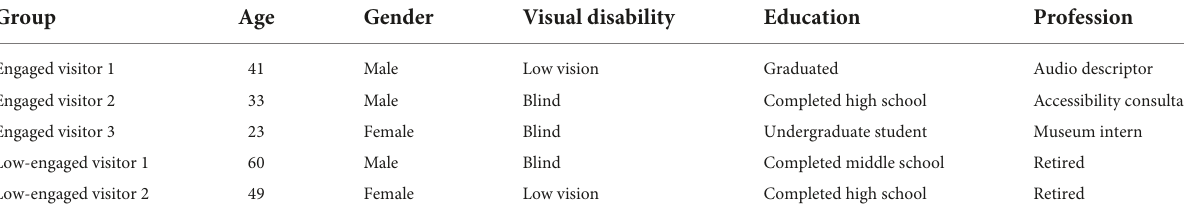
TABLE 1 Research participants’